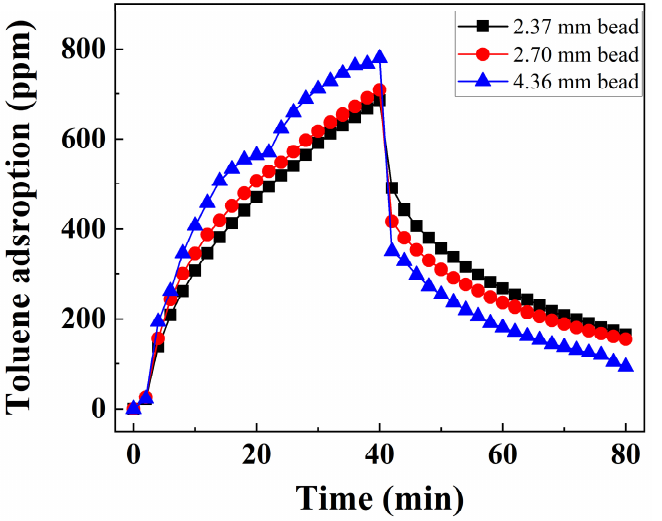
Figure 6. Toluene adsorption–desorption curve of Alg-PCH depending on the bead size with 40 min cycle. Table 4. Summarized toluene adsorption capacities and BET surface area of various adsorbents.